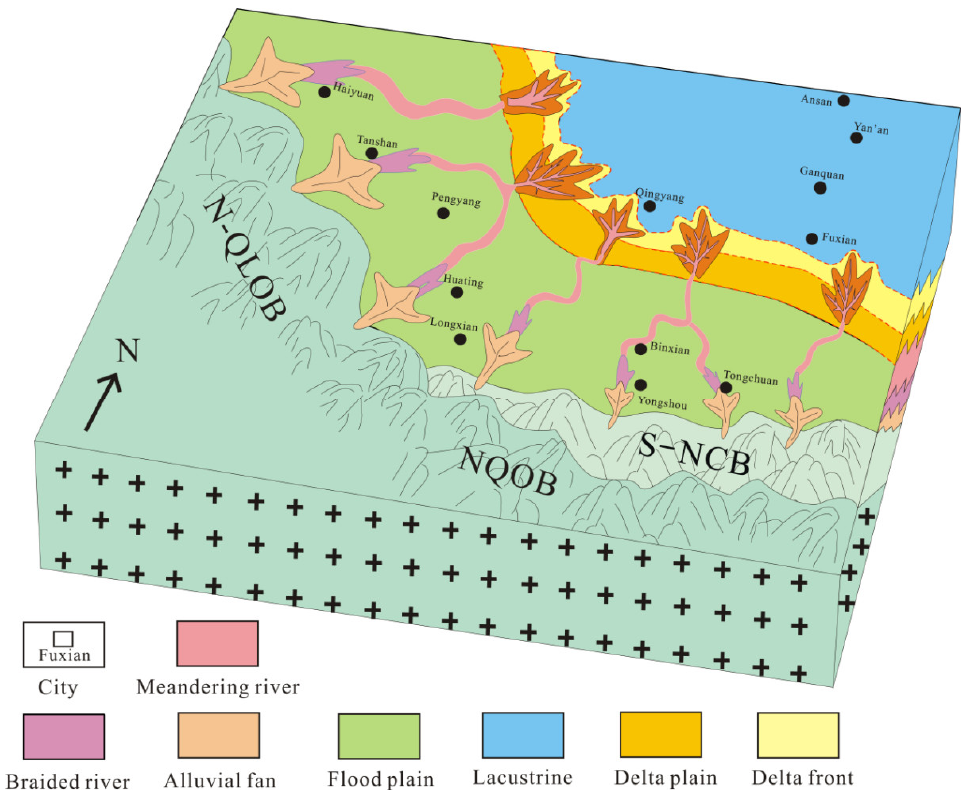
Figure 10. Sketch of the paleogeography and sedimentary boundary of the basin in the Zhiluo Formation in the southern Ordos basin.